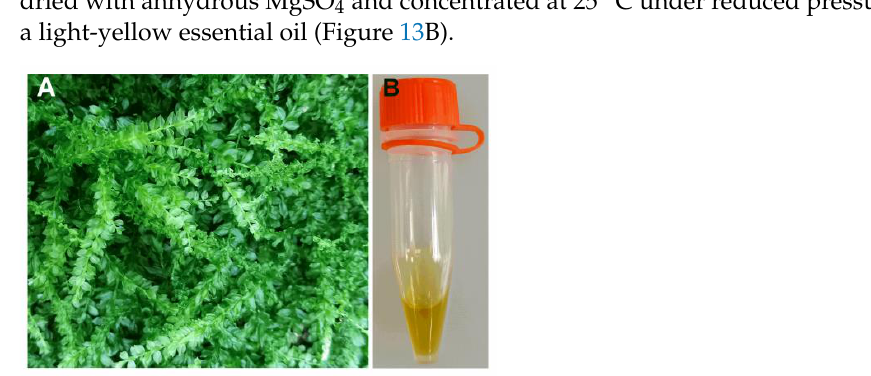
Figure 13. Morphological observation of the aerial parts of ( A ) P . acutum and ( B ) essential oil ex- tracted by SDE method. by SDE